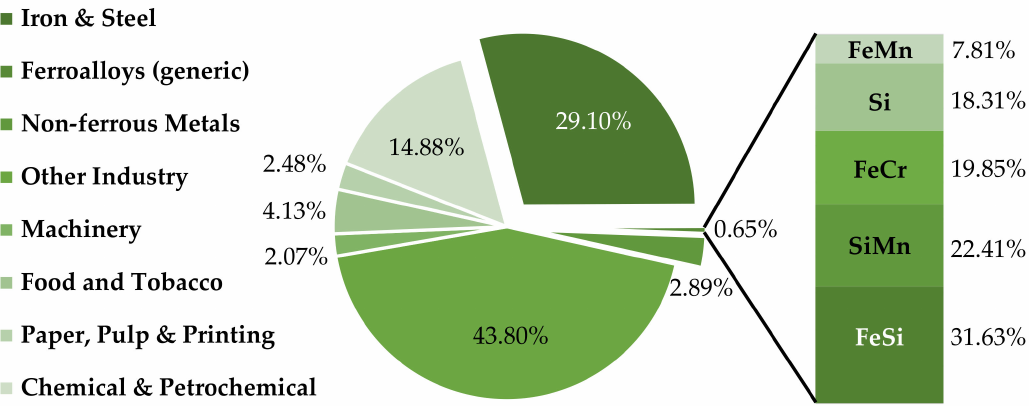
Figure 2. Global greenhouse gas Emissions by industries in 2016, based on data from [23,24] and share of the generic CO 2 emissions of